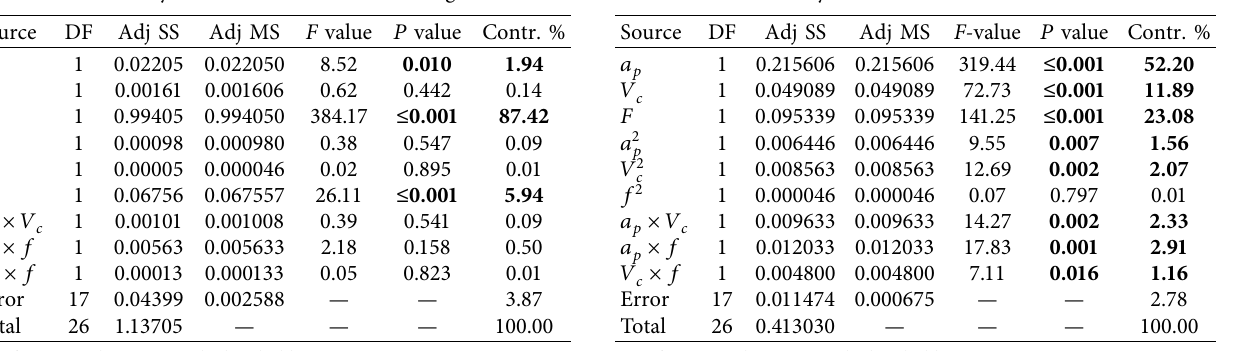
Table 9: Analysis of variance for electric